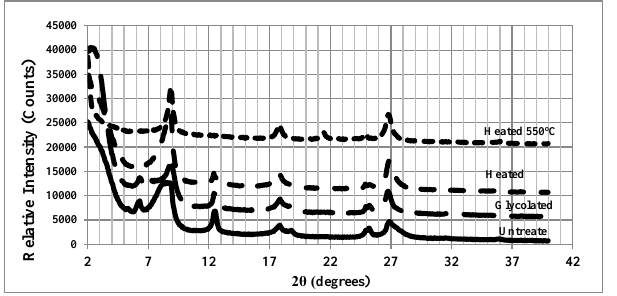
Figure 3: X-ray diffractograms of duplicate sample from Outcrop 1 (Scans R 4920)